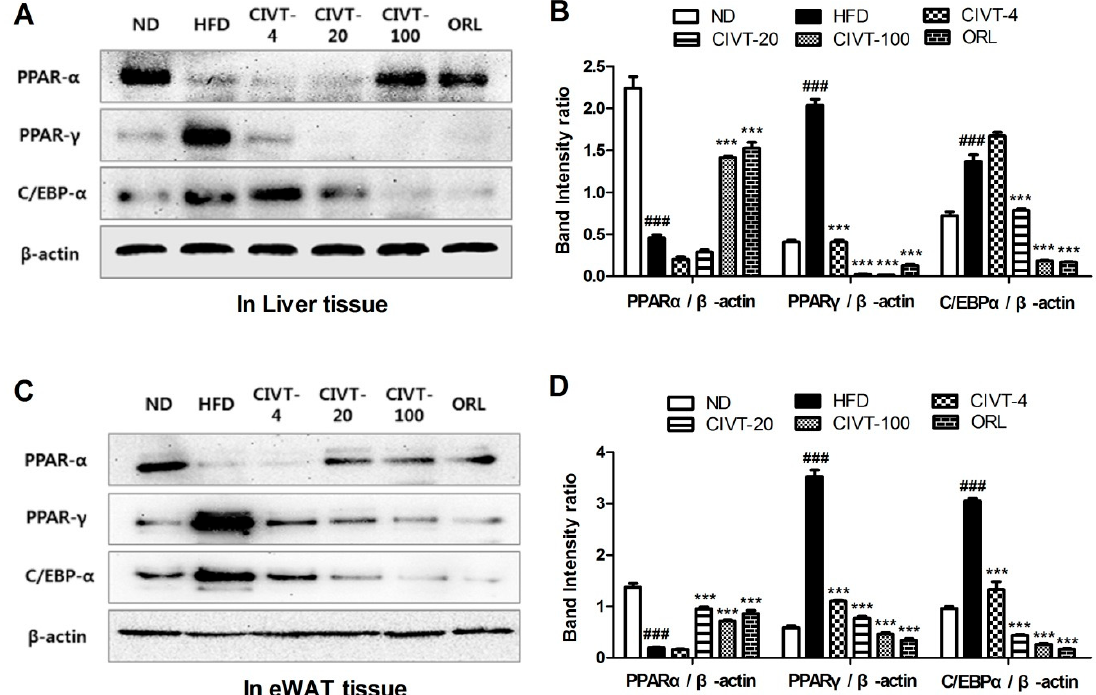
Figure 4. Effects of CIVT on the protein expression levels of transcription factors of adipogenesis in HFD-fed obese mice. Protein expression levels of PPAR- α , PPAR- γ and C/EBP- α in liver tissues were analysed using western blotting ( A ). The intensities of the relative band in the western blot are shown as bar graph as follow: PPAR- α / β -actin, PPAR- γ / β -actin and C/EBP- α / β -actin ( B ). Protein expression levels of PPAR- α , PPAR- γ and C/EBP- α in eWAT tissues were analysed using western blot ( C ). The intensities of the relative band of western blot were shown as a bar graph as follow: PPAR- α / β -actin, PPAR- γ / β -actin and C/EBP- α / β -actin ( D ). Values represent the means ± SEMs of three independent experiments. Data were analysed by Bonferroni correction for post-hoc test. ### p < 0.001 versus the ND group; *** p < 0.001 versus the HFD group.